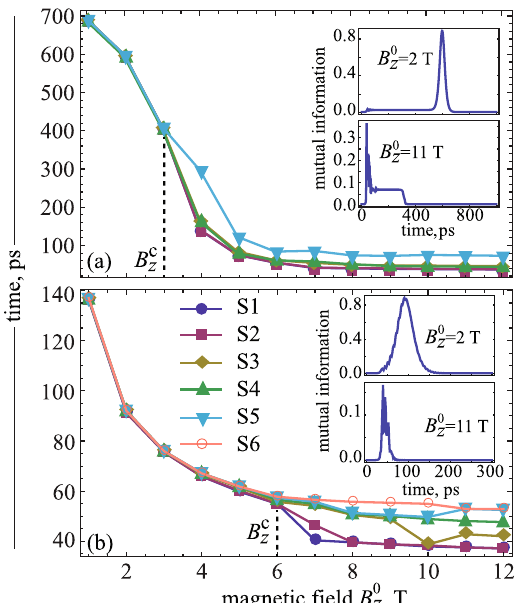
Figure 4. Dependence of a spin reversal time [( a ) and ( b )] for 5- and 6-atomic chains on the external magnetic 0 , respectively. Insets: Time evolution of two-particle mutual information between edge spins field amplitude B z 0 = 2 T and B 0 = 11 T (for the 5-atomic chains the effects of the corresponding chains under the fields B z with B z z of t 0 of B x and amplitude B x 0 are found, see Supplementary information, Figs S2 and